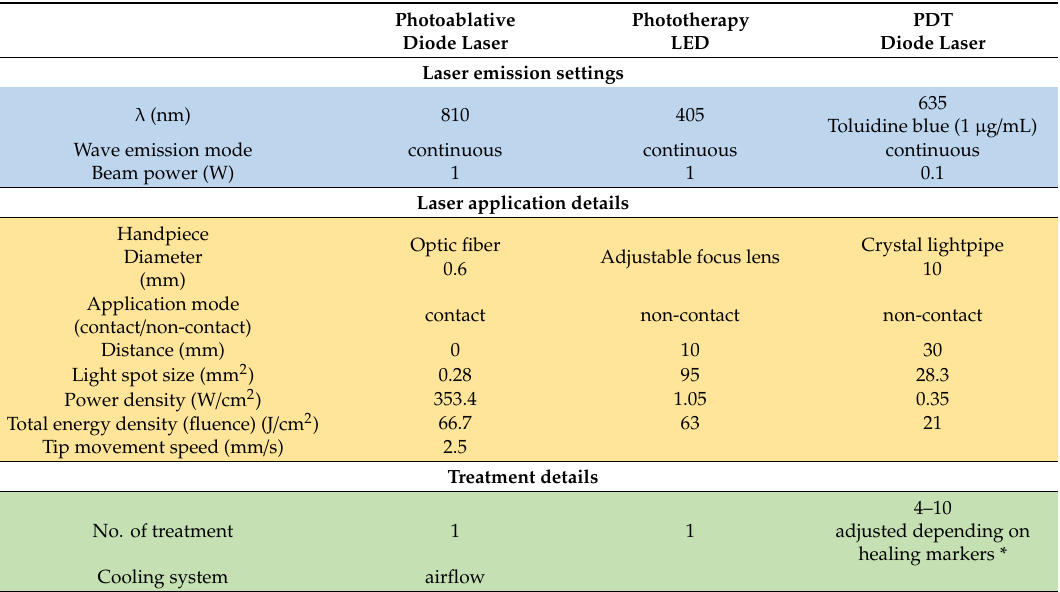
Table 5. Suggested parameters for multi-photonic (iPAPD) periodontal therapy